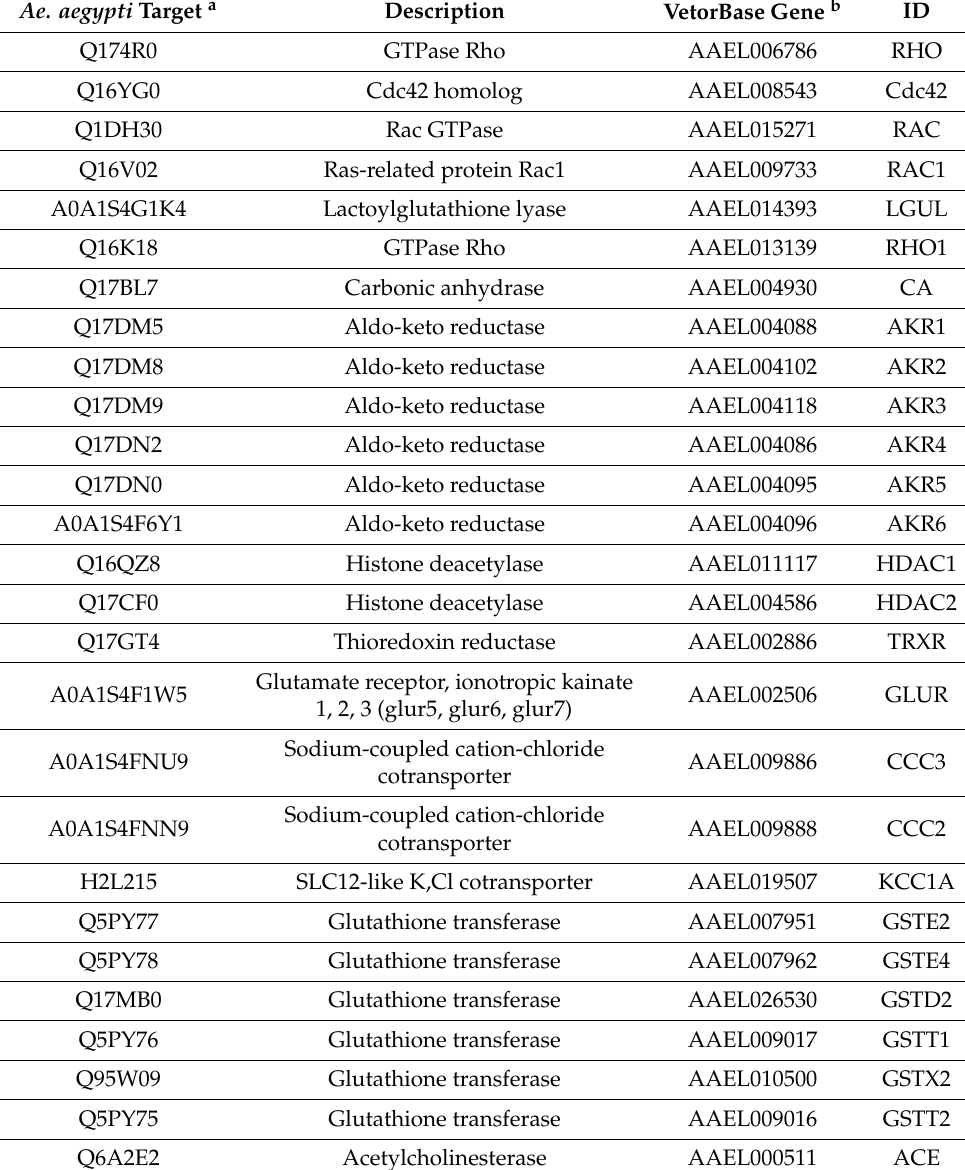
Table 2. Potential targets of the series of cinnamic acid derivatives in Ae. aegypti